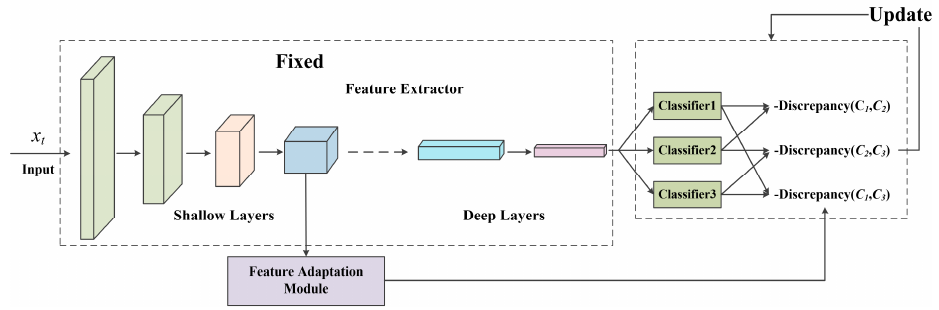
Figure 6. Maximizing cross-classifier discrepancy for the target domain.